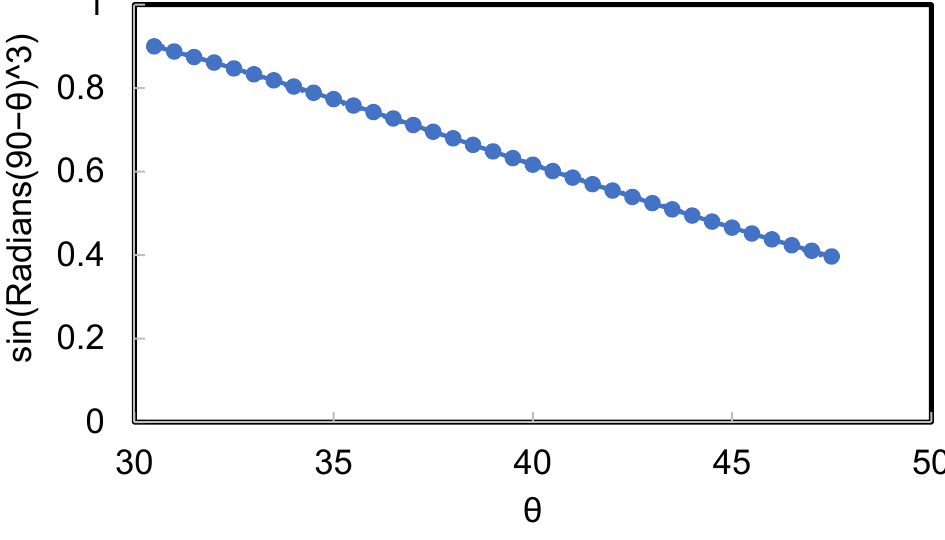
Figure 4. The attenuation coefficient (sin ( Radians ( 90 − θ ) 3 ) ), as a function of θ (in degrees), and the local incidence angle. This attenuation coefficient was used to correct for the dependence of radar brightness β 0 values on the local incidence angle.